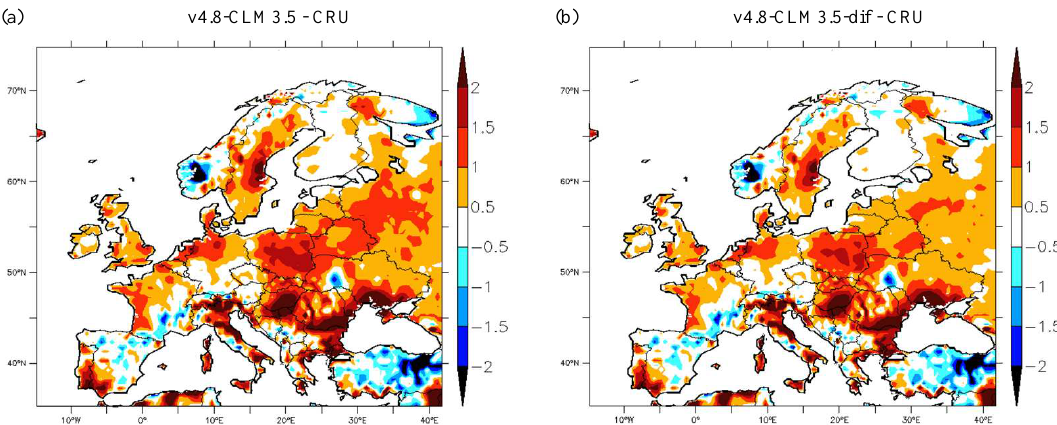
Fig. 8. Summer (JJA) mean 2-meter temperature bias (model minus CRU) for experiments v4.8-CLM3.5 and v4.8-CLM3.5-dif. The considered time period is 1986-2006.